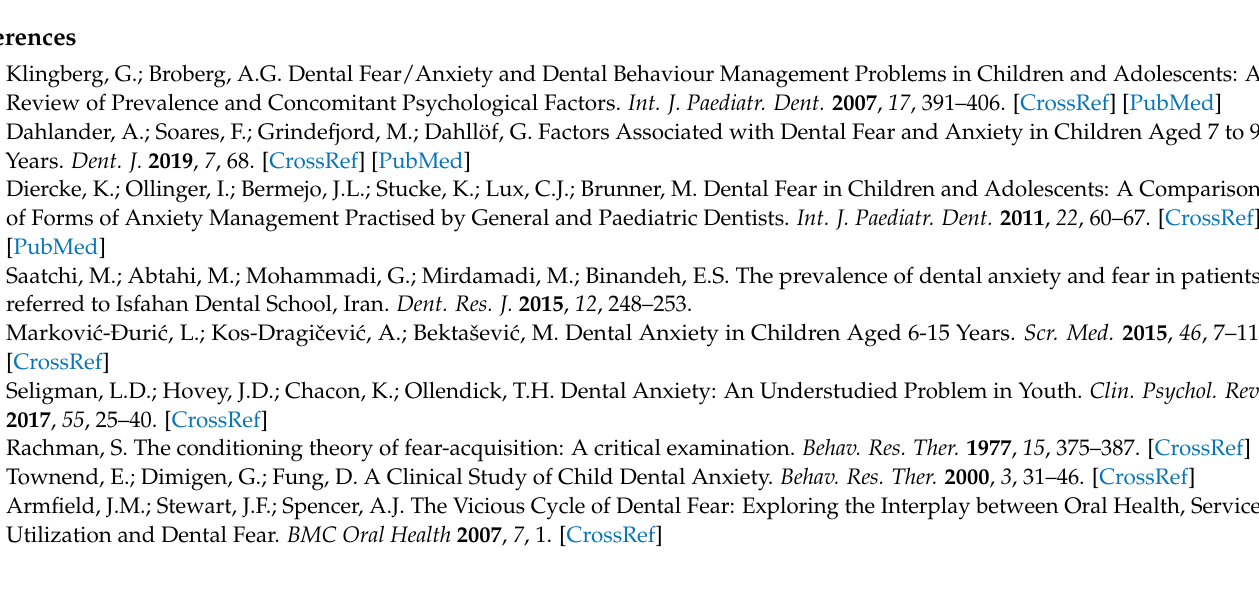
Figure A1. Corah Dental Anxiety Scale (CDAS) questionnaire.